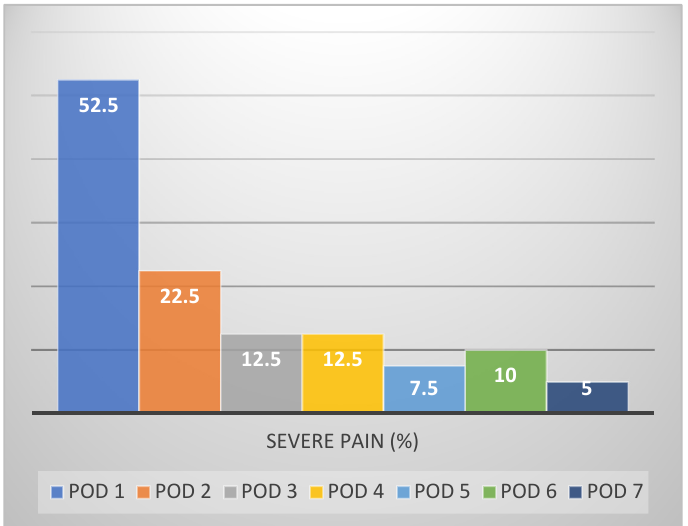
Figure 1. Percentage of individuals experiencing severe pain (>2) over post operative days (POD). Consumption of analgesics also declined gradually over the first three postoperative days (80%, 45%, and 30%,